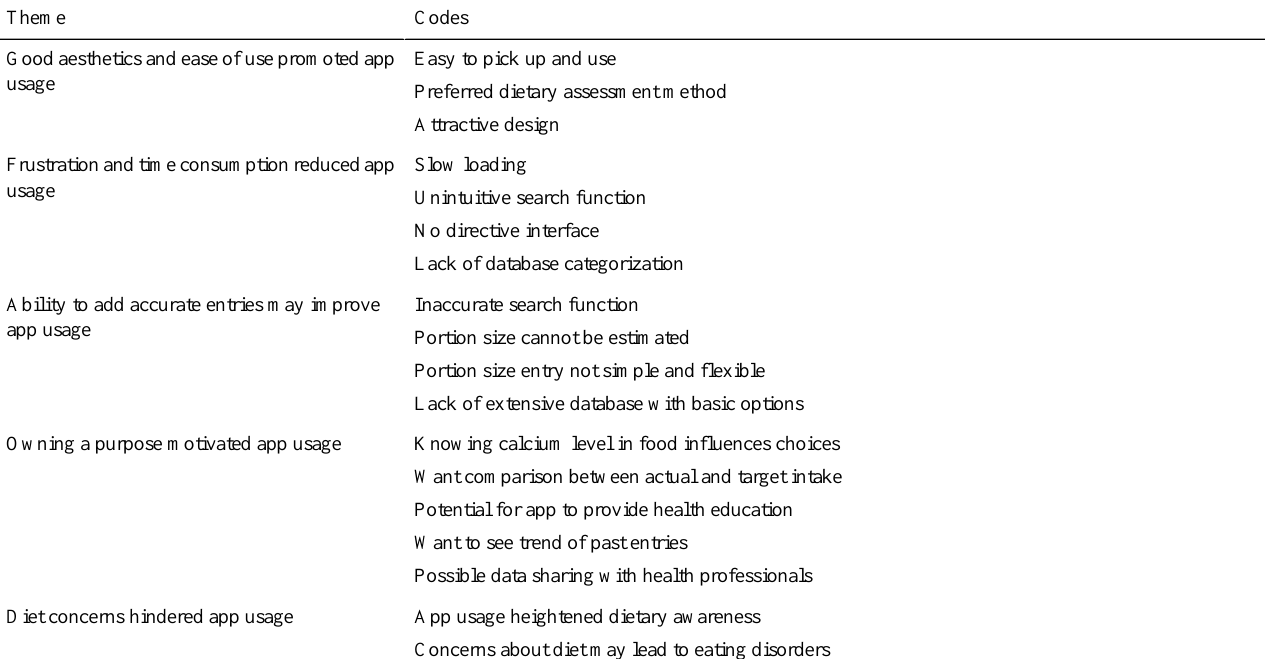
Table 1. Themes and codes derived from qualitative analysis of Calci-app mobile focus group